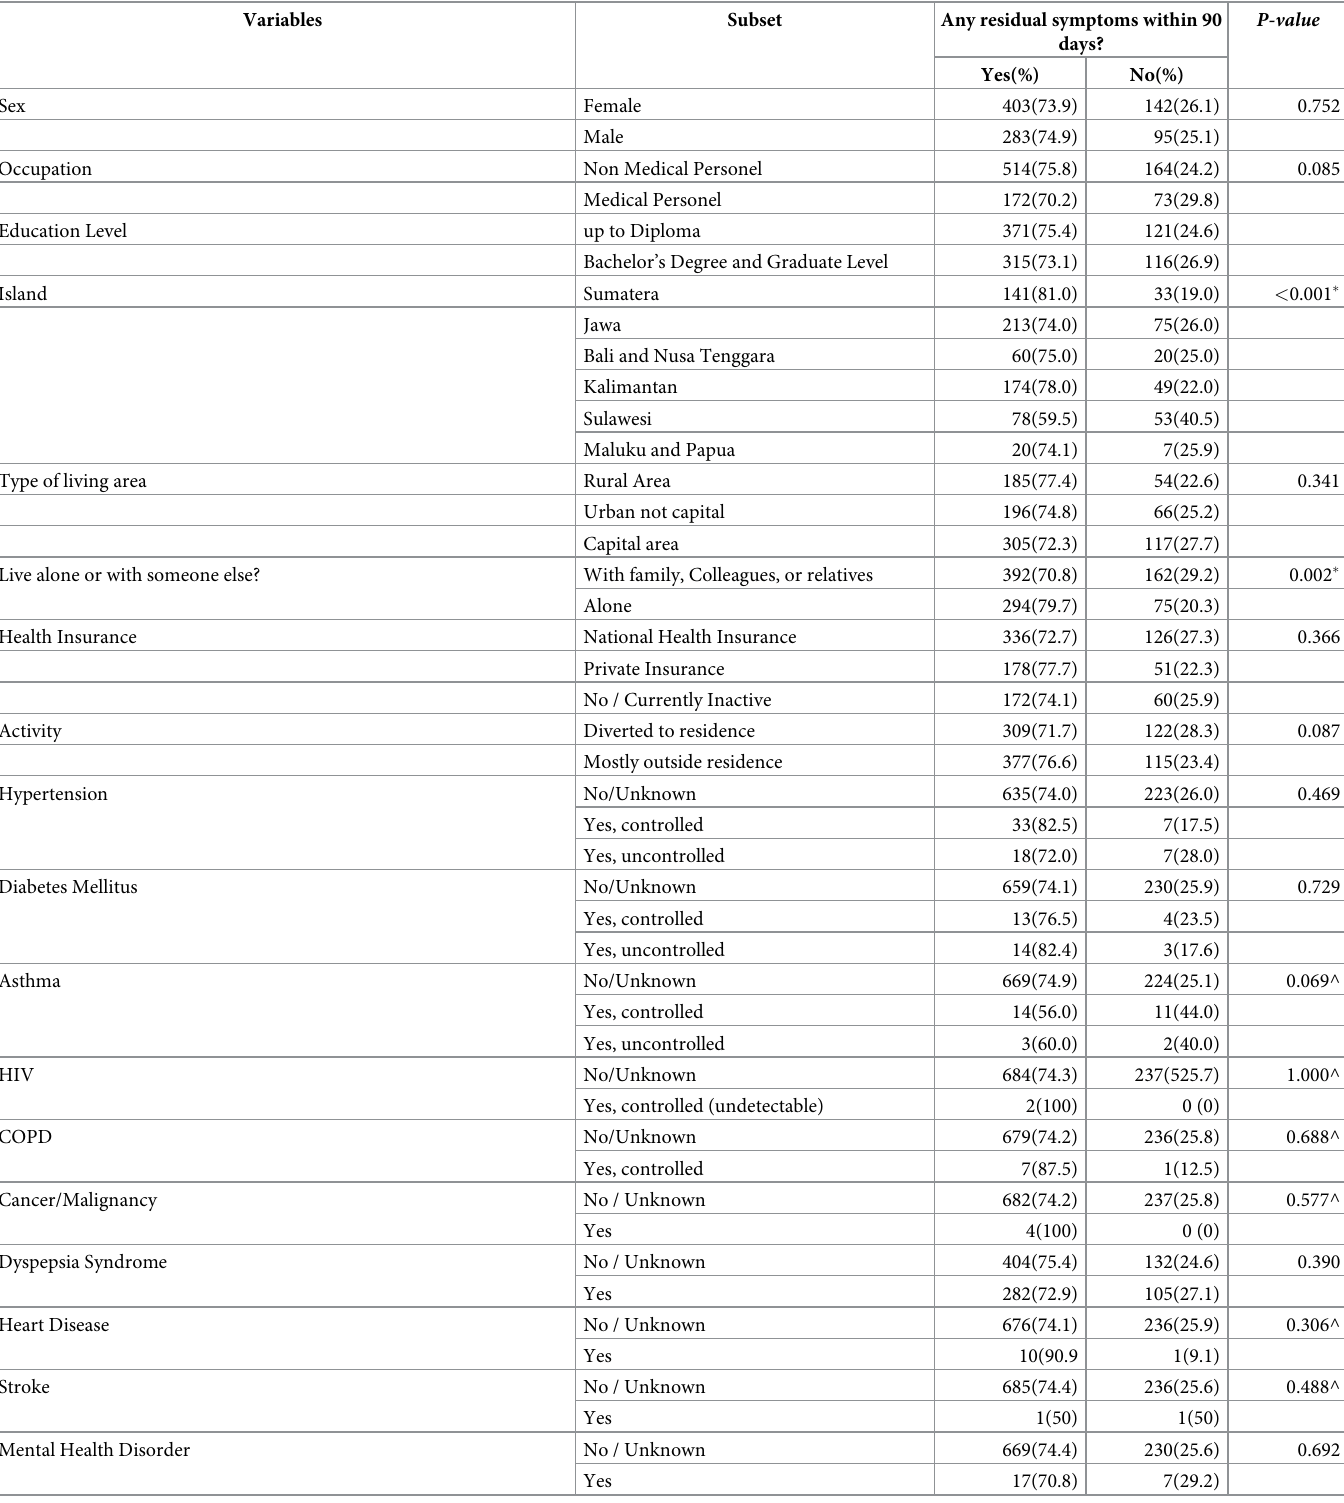
Table 1. Characteristics of participants (n =